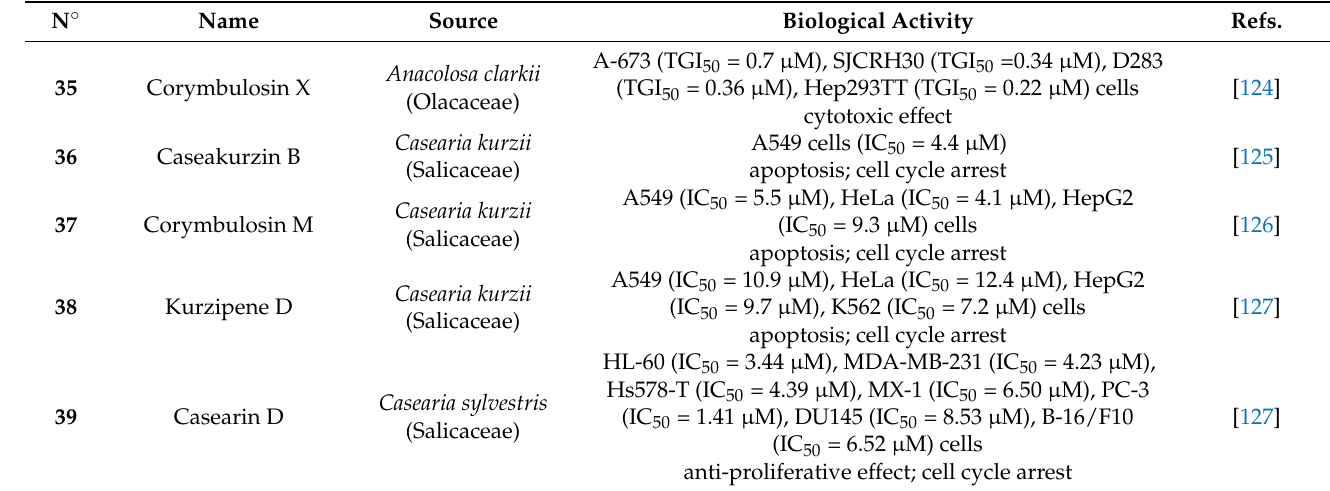
Table 3. Sources and biological activities on cancer cell lines of clerodane